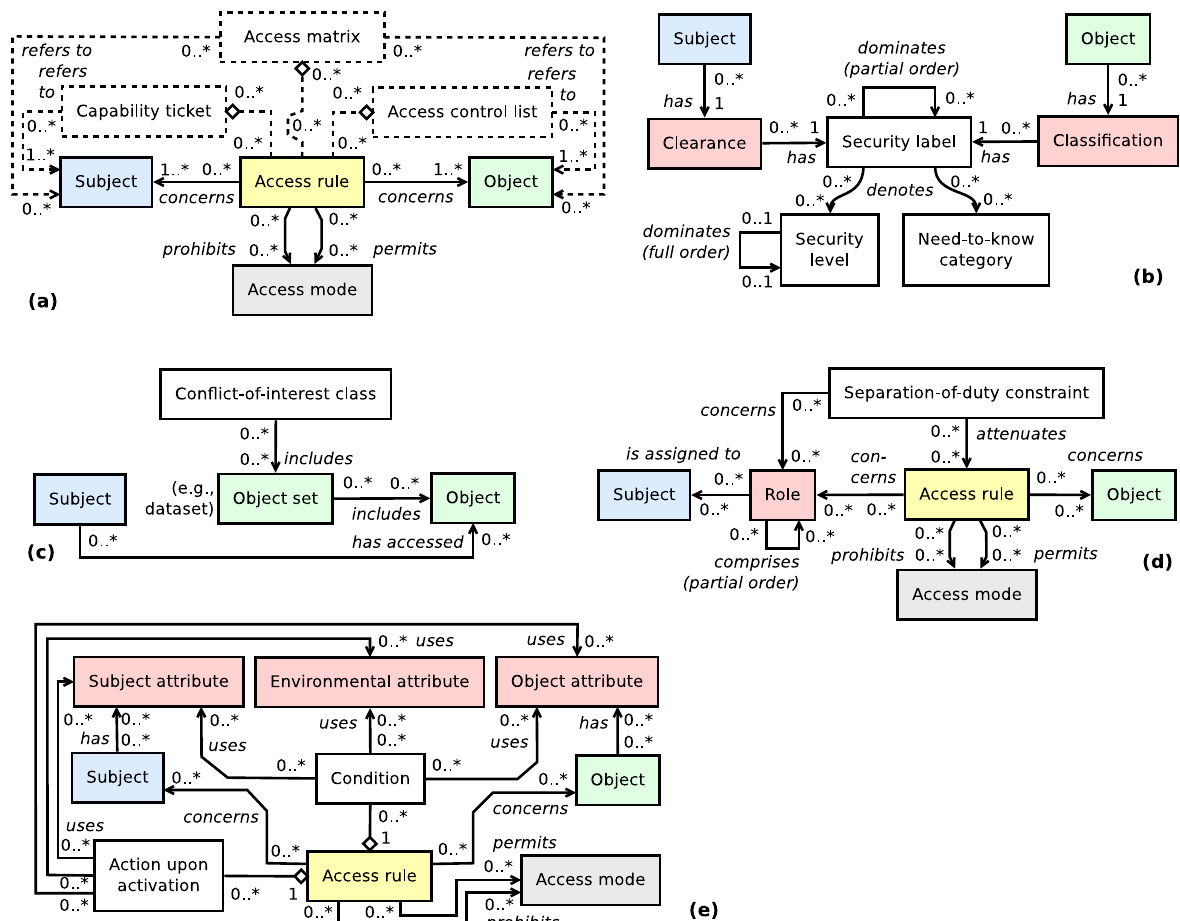
Figure 2. Generic metamodels for expressing configurations of (a) DAC; (b) BLP and Biba; (c) Brewer-Nash (Chinese wall); (d) RBAC 0 , 1 , 2 , 3 ; and (e) ABAC. In (a), the dashed items describe implementation